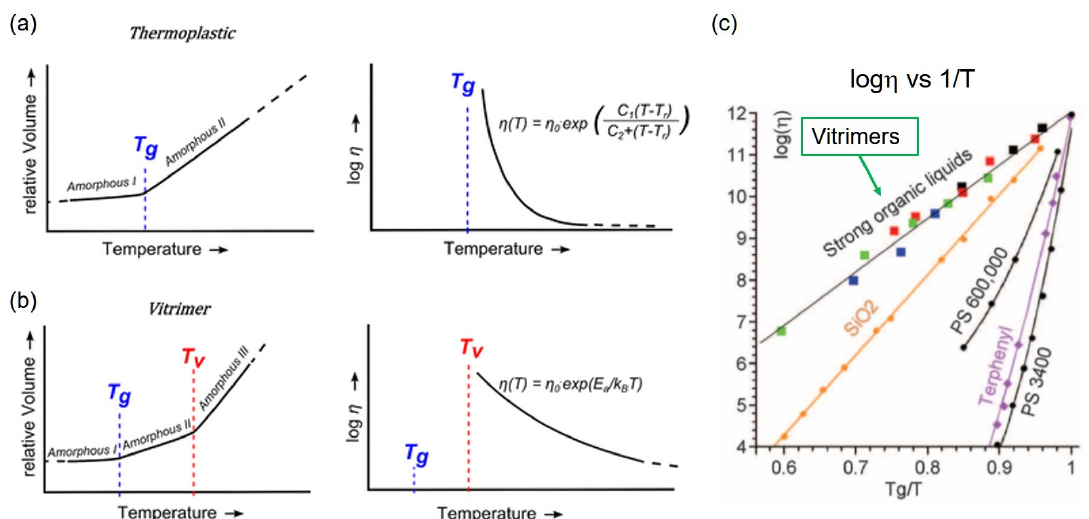
Figure 3. Correlation chart of relative volume vs. temperature and viscosity vs. temperature for ( a ) thermoplastics and ( b ) vitrimers. Reprinted with permission from ref. [24]. Copyright (2012)